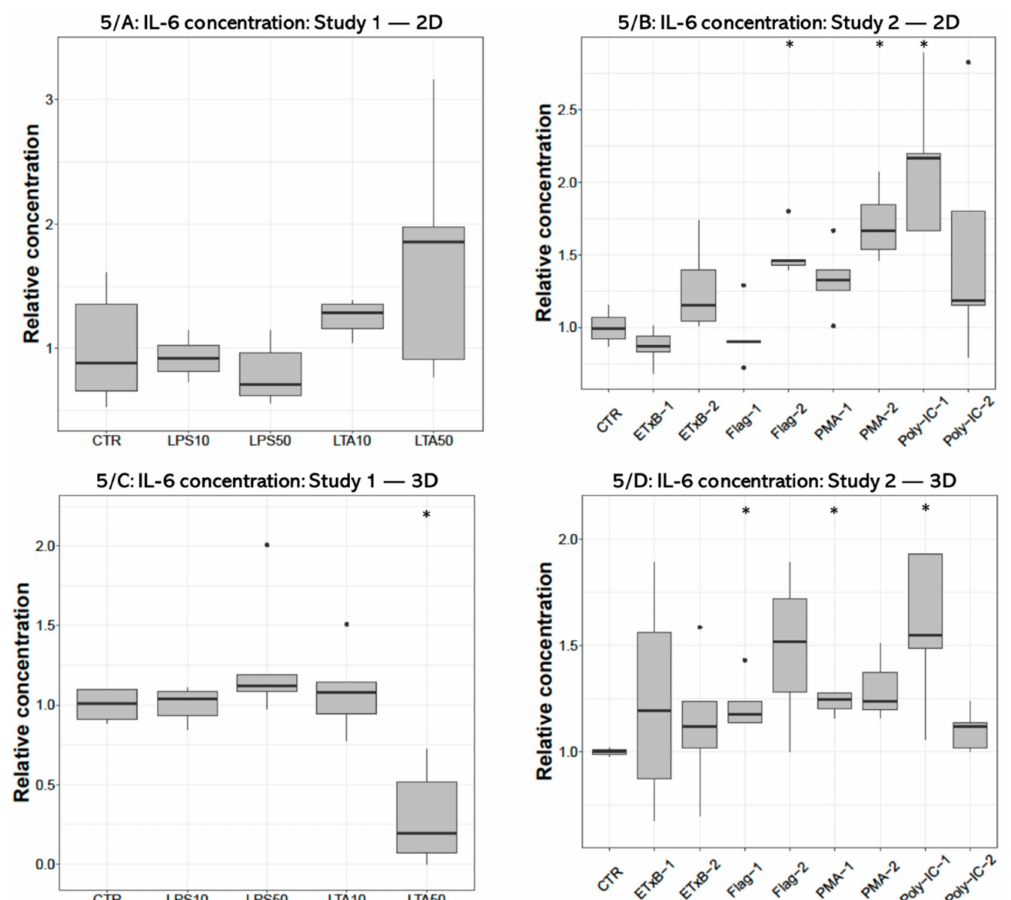
Figure 5. Boxplots showing the interleukin-6 (IL-6) concentration in cell culture media of hepatocyte—non-parenchymal cells in (Study 1: ( A ) and Study 2: ( B )) and 3D (Study 1: ( C ) and Study 2: ( D )) co-cultures detected by a chicken specific ELISA assay (n study 1 = 6/group, n study 2 = 5/group). Relative concentrations were calculated by considering the mean value of control cultures as 1. The “CTR” refers to control cells that received none of the treatments. The treatments were: LPS10 and LPS50 = 10 and 50 µ g/mL lipopolysaccharide (LPS) from Escherichia coli , LTA10 and LTA50 = 10 and 50 µ g/mL lipoteichoic acid (LTA) from Staphylococcus aureus , ETxB-1 and -2 = 20 and 50 µ g/mL subunit B of heat-labile enterotoxin of Escherichia coli , Flag-1 and -2 = 100 and 250 ng/mL flagellin from Salmonella Typhimurium, PMA-1 and -2 = 100 and 1000 ng/mL phorbol myristate acetate (PMA), poly-IC-1 and -2= 50 and 100 µ g/mL polyinosinic polycytidylic acid (poly I:C). Asterisks over the boxes refer to significant differences compared to “CTR” cells within the same cell culture model and the same study. * p <